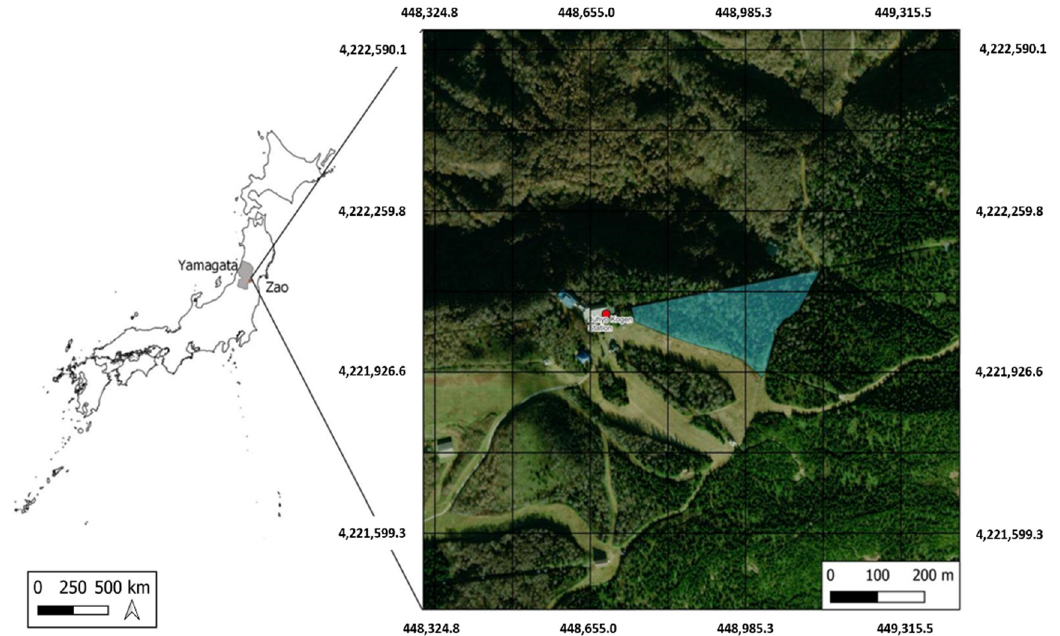
Figure 1. Location of the study site in the Zao Mountains next to Juhyo Kogen ropeway station. The fir trees are mixed with deciduous broadleaf species on the selected slope.